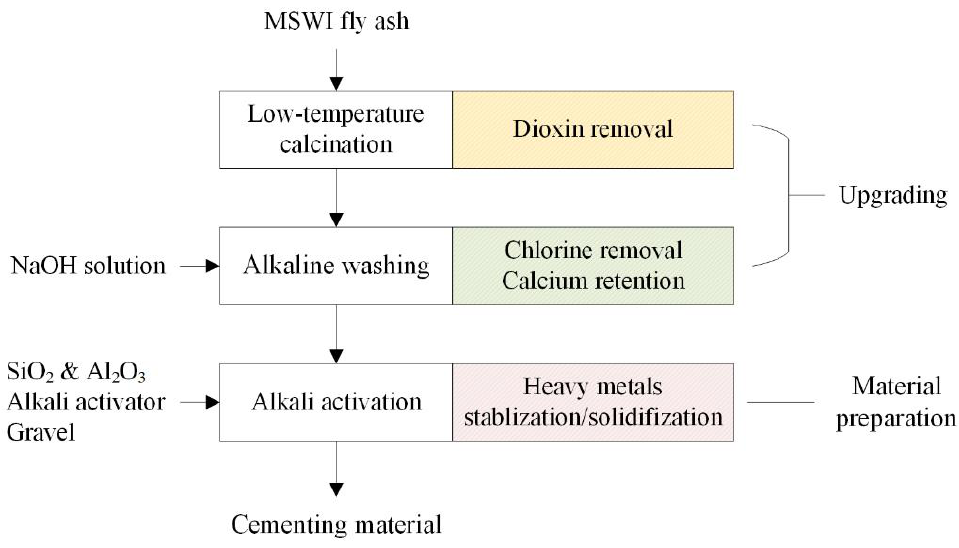
Figure 1. The process of MSWI fly ash upgrading and alkali activated material preparation.